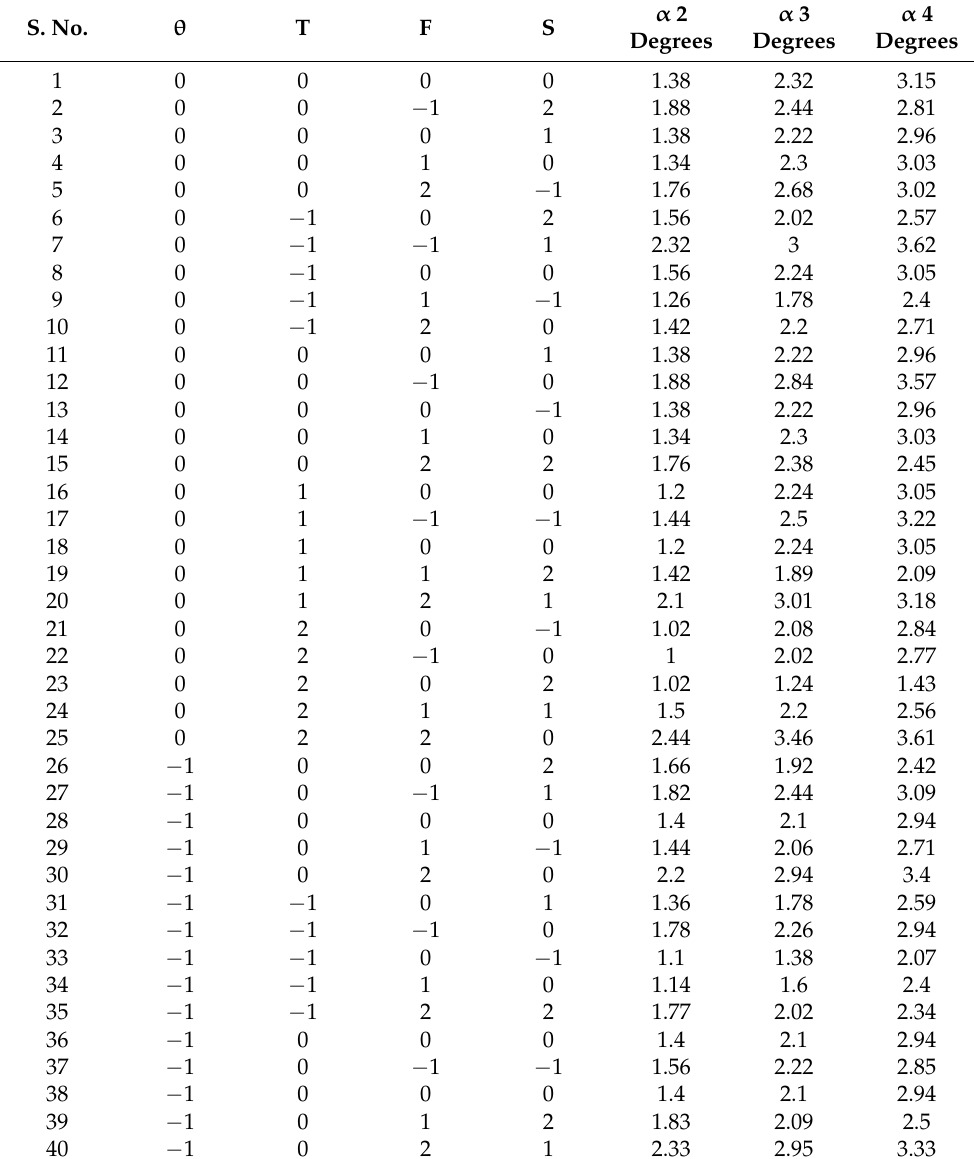
Figure 5. Photograph showing angular distortion. Table 3. Design matrix and measured value of angular